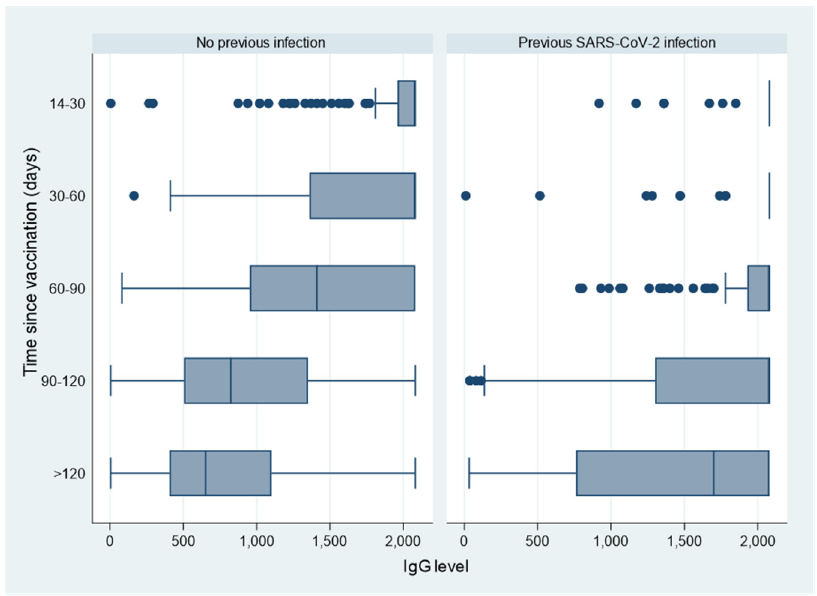
Figure 2. Box-plot of IgG values according to distance (days) between vaccination and serological test on May 2021, by previous SARS-CoV-2 infection.